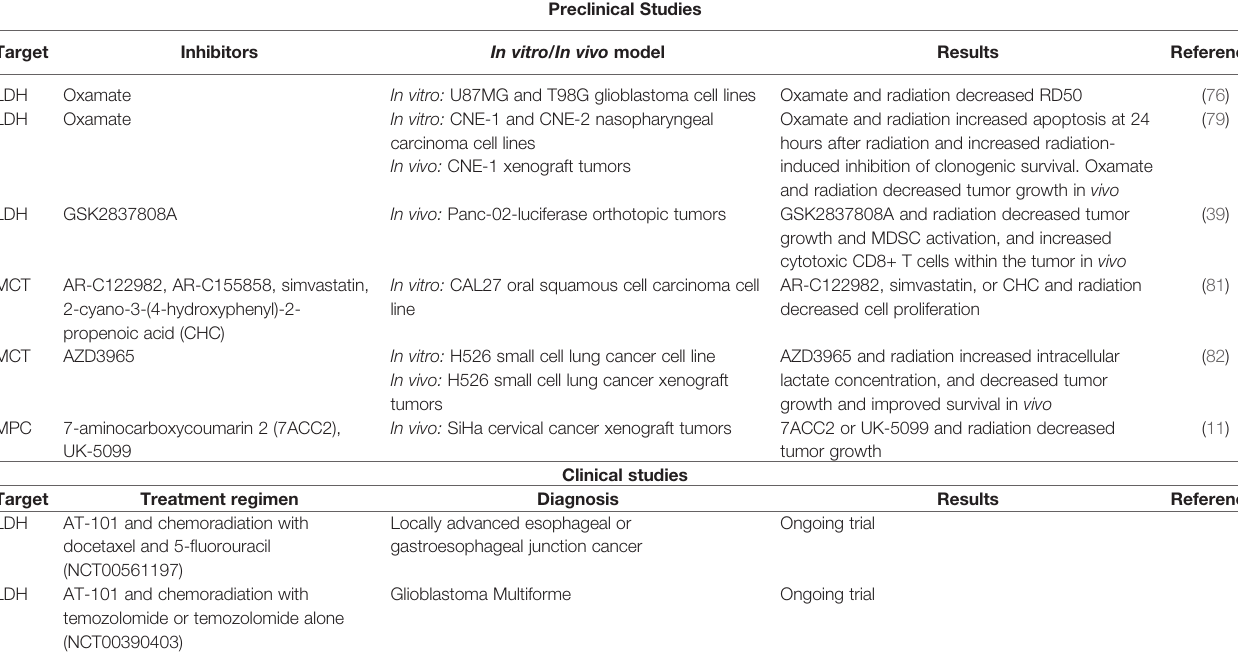
TABLE 1 | Preclinical studies and clinical trials exploring lactate pathway targets with radiotherapy in